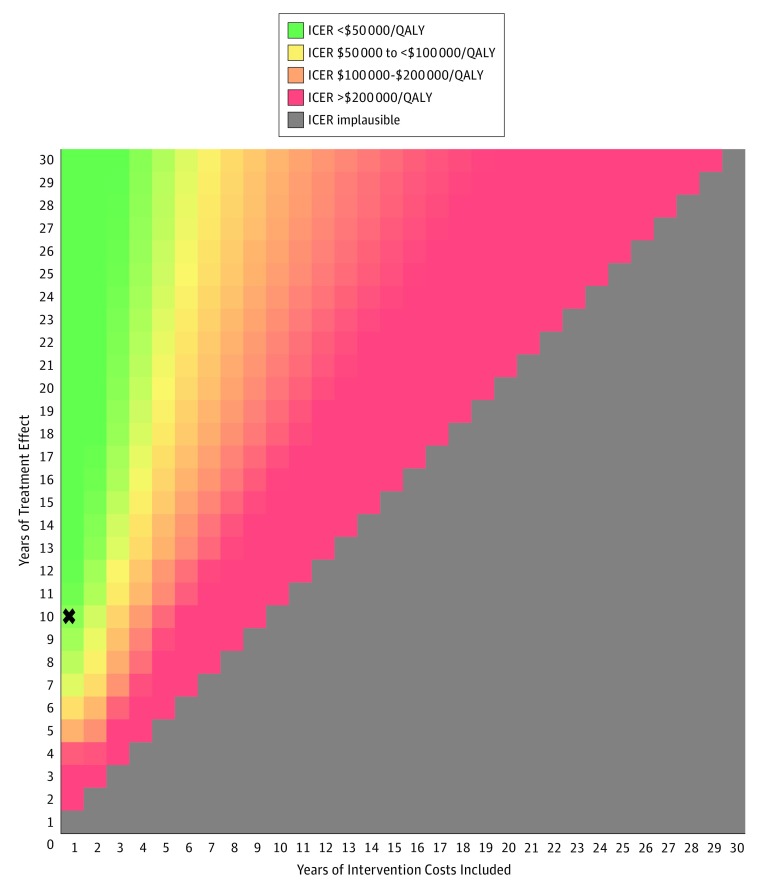
Two-Way Sensitivity Analysis Showing the Incremental Cost-effectiveness Ratios (ICERs) for the Shared-Incentives Strategy Compared With the Trial Control for Different Combinations of Low-Density Lipoprotein Cholesterol Level Reduction Waning and Years of Intervention CostsThe regions show combinations of values by color that resulted in ICERs (2017 US dollars) for the shared-incentives strategy compared with the trial control strategy per quality-adjusted life-year (QALY). Implausible results indicate years when intervention costs are included but treatment effects are not observed. The X indicates the base-case assumption and result (treatment effect linearly wanes to 0 by year 10).